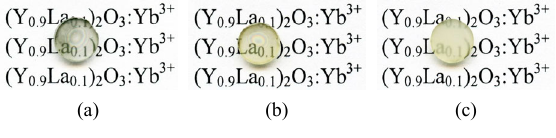
Fig. 5 (Y 0.86 La 0.09 Yb 0.05 ) 2 O 3 ceramics prepared using Alpha-Micro (a), Alpha-Nano (b), and ITO-V (c) Y 2 O 3 powders by vacuum sintering at T = 1750 ℃ for 10 h.